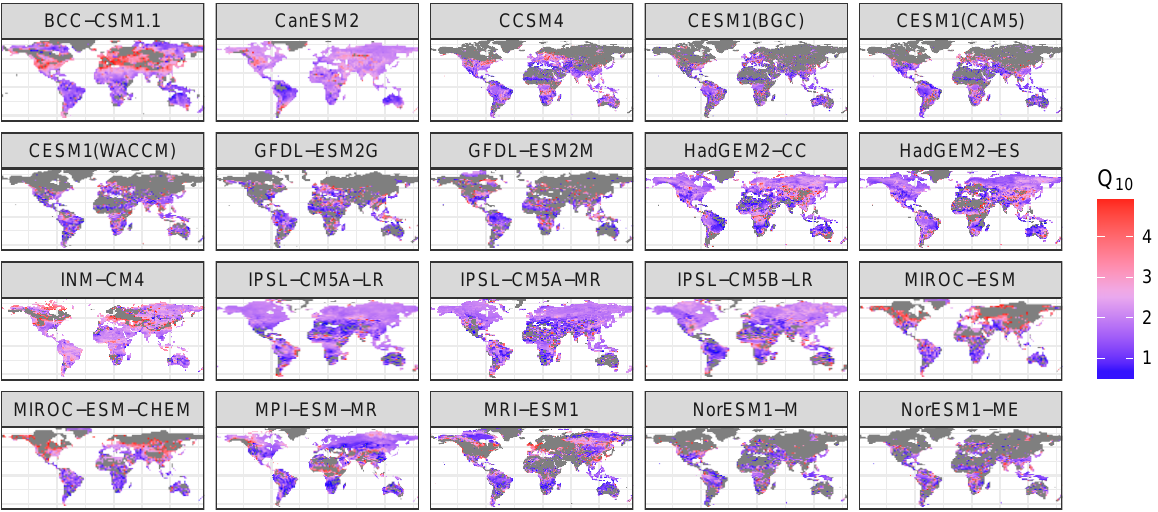
Figure 3. Inferred Q 10 values from the Earth system models (CMIP5, RCP 8.5). The color scheme is centered around the field-driven Q 10 median value of 2.2. Grey indicates non-typical Q 10 values that were nonfinite, less than 0.5, or greater then